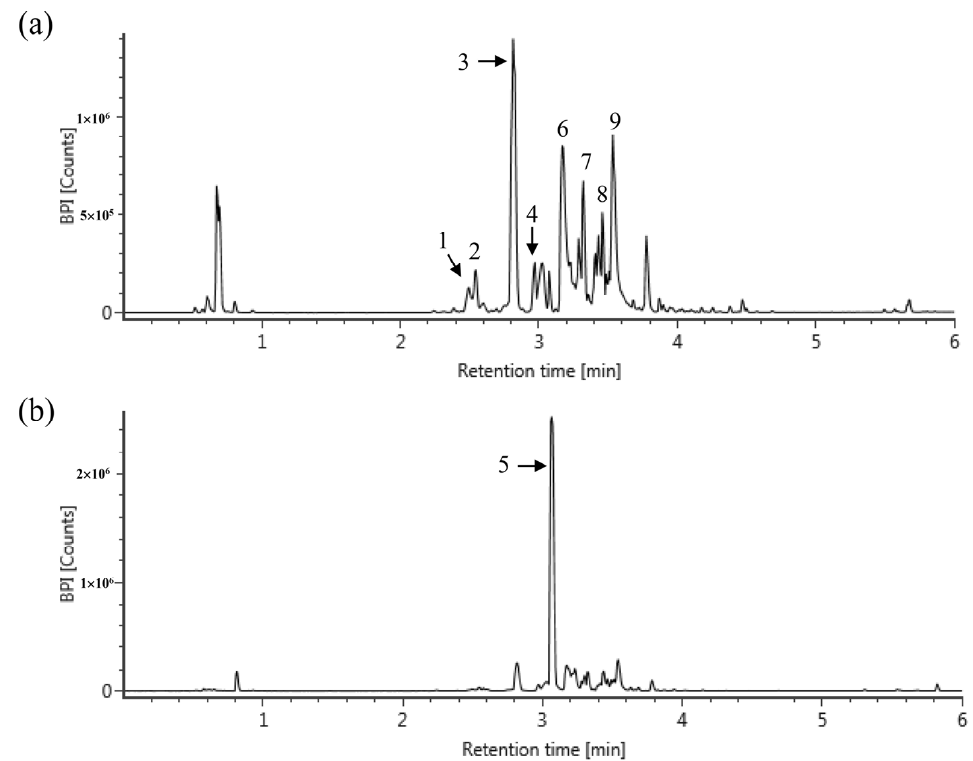
Figure 6. Representative mass chromatograms of CLE. The mass chromatograms were obtained using UPLC-Q-TOF-MS with positive ( a ) and negative ( b ) mode, and nine compounds were identified. (1) Gallocatechin (GC); (2) Epigallocatechin (EGC); (3) GC dimer; (4) catechin; (5) caffeine; (6) Epigallocatechin gallate (EGCG); (7) Quercetin 3-glucosylrutinoside; (8) kaempferol 3-glucosylrutinoside; (9) Catechin gallate (GC).